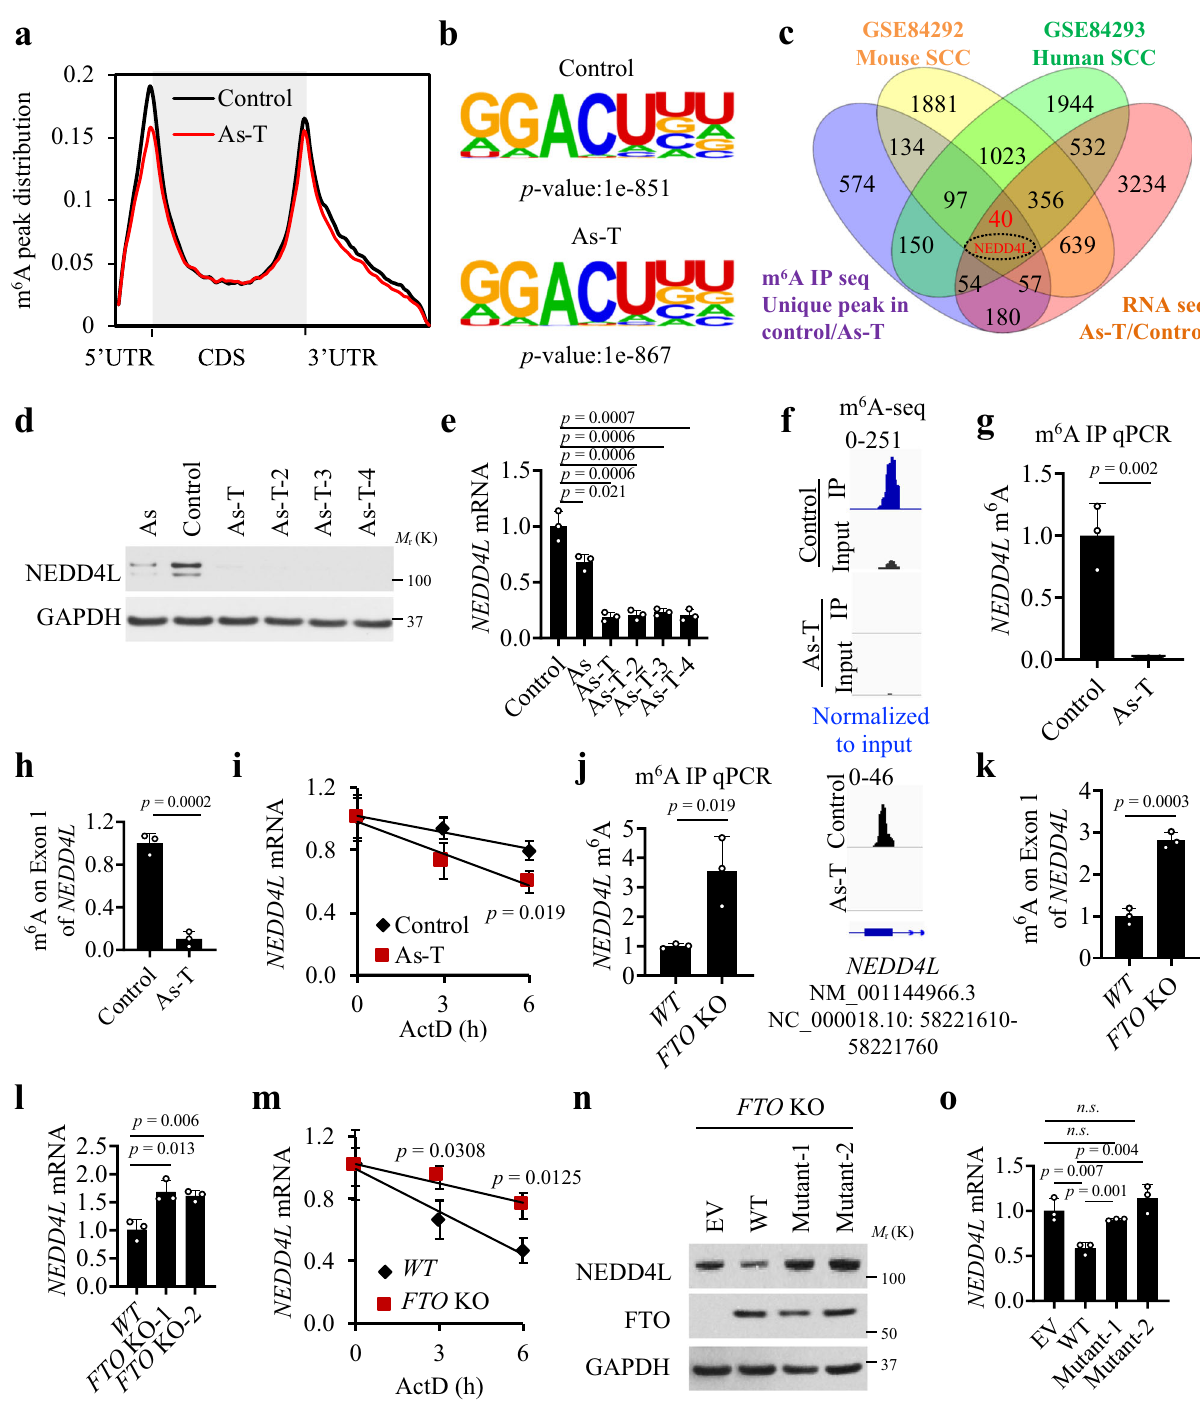
(Supplementary Fig. 4e). FTO deletion decreased the levels of Dvl2 and β -catenin and WNT activity, which was prevented by NEDD4L knockdown (Supplementary Fig. 4e-f). Future investi- gation is needed to elucidate the role of other pathways, including the TGF- β 41 and PI3K/AKT 42 pathways, in the function of NEDD4L in skin cancer. These results demonstrate that NEDD4L is a critical downstream target of FTO responsible for its function in arsenic-induced malignant